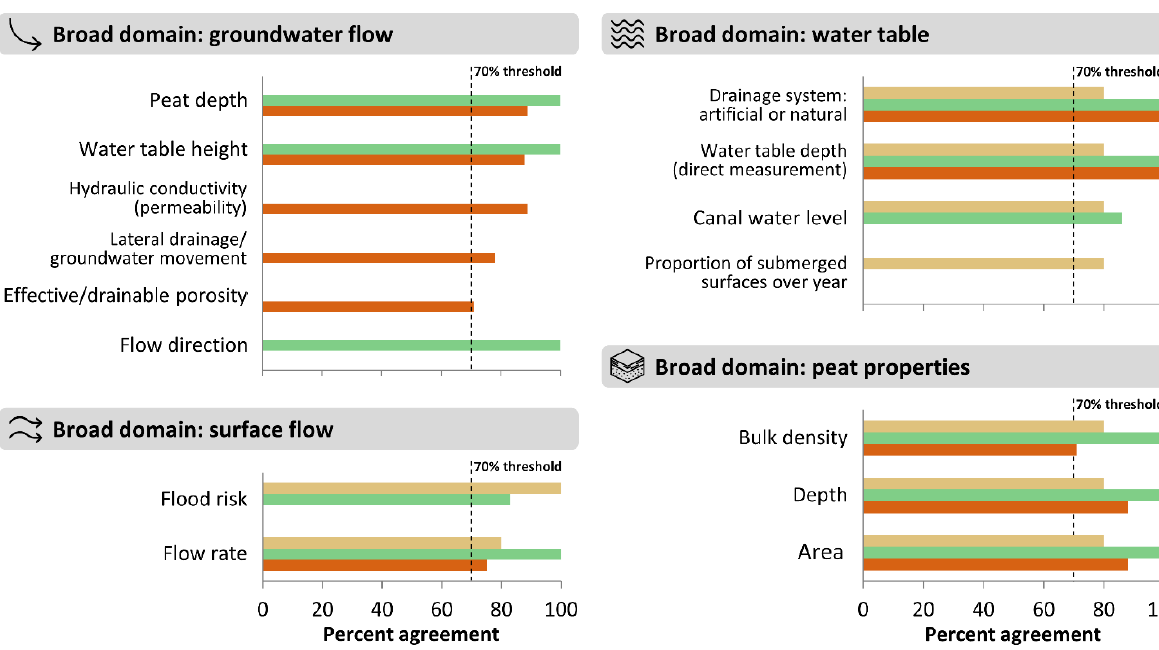
Figure 8. Hydrology core domain set, and the constituent target domain outcomes agreed by ≥ 70 % of respondents as potential high priorities for measurement in tropical peat swamp research or monitoring, depending on the objective or focus of the research or restoration project (based on nine expert responses). Scores < 70 % are not